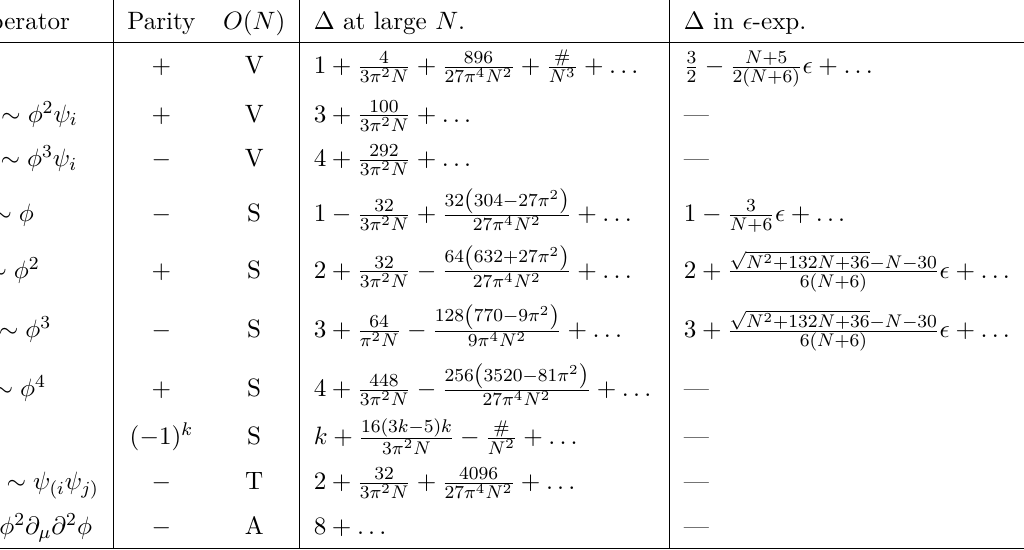
Table 2 . Large- N [15, 29, 32–38] and (cid:15) -expansion estimates [19, 25–31] for the scaling dimensions in the GNY model. The results for ∆ denoted by # indicate known expressions that have been omitted here for concision. ∆ positive correction at O (1 /N 3 ) that can be found in [34] and ∆ k > 1 ) at O (1 /N 2 ) that can be found in